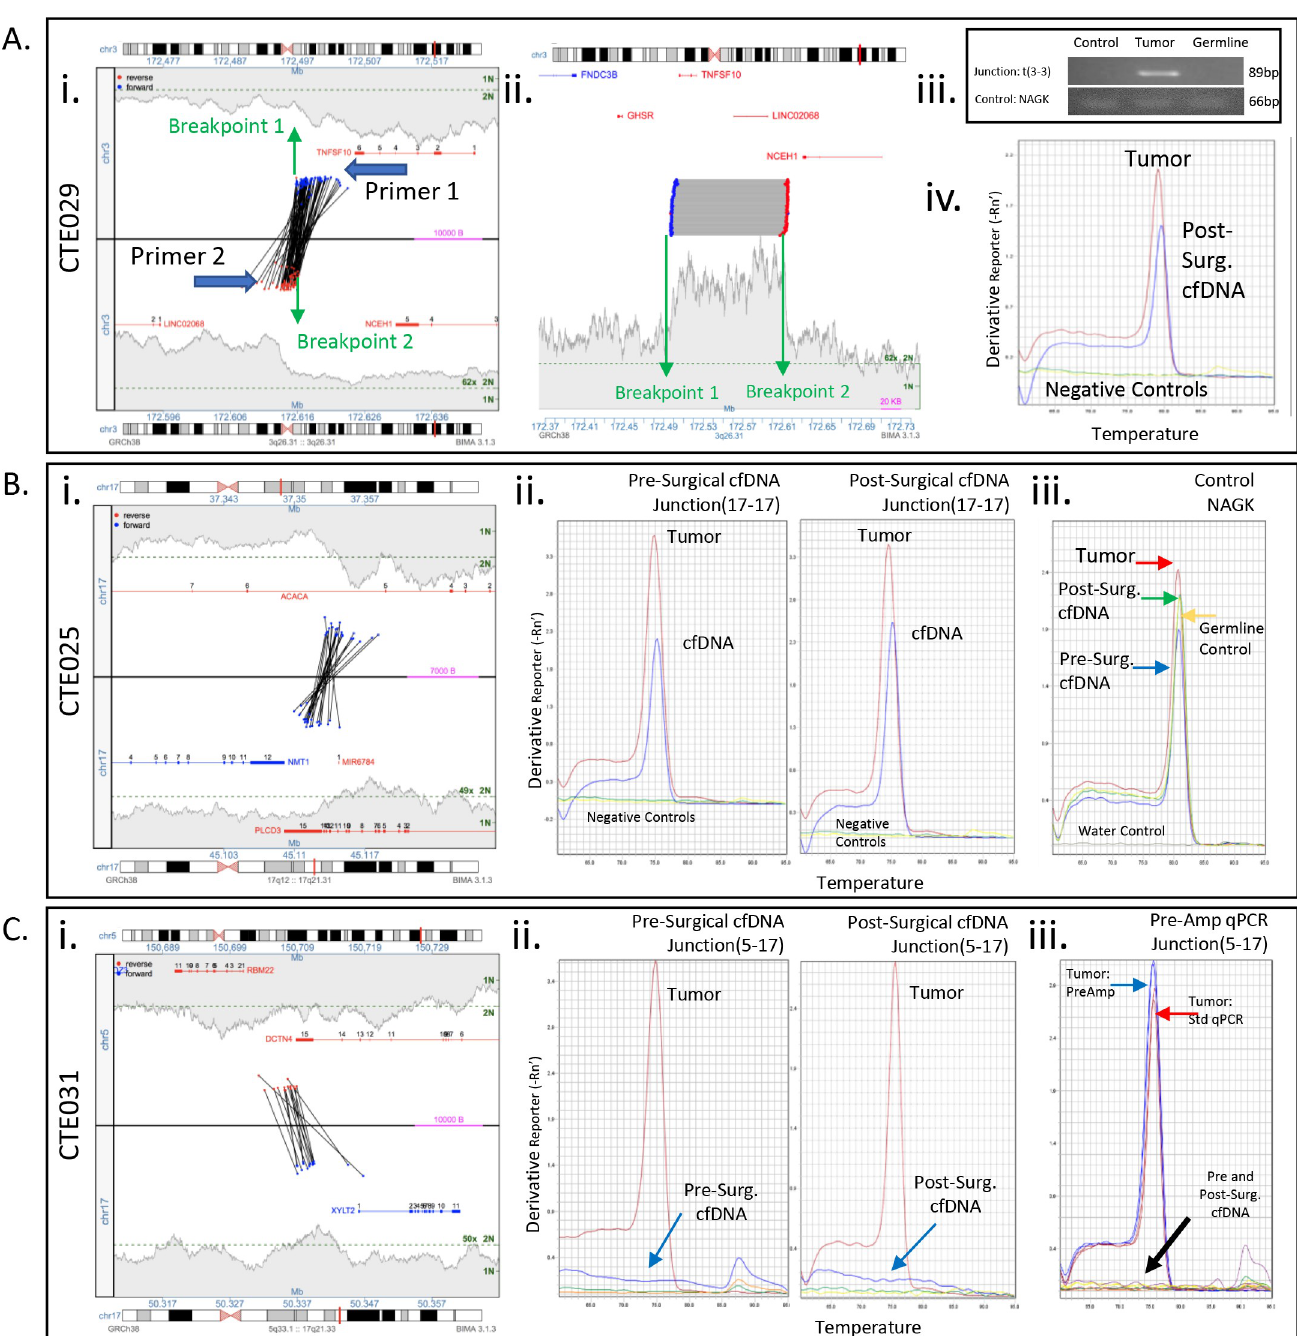
Fig 3. Junction primer design and qPCR cfDNA detection results. (A) Case CTE029. Left Panel : Junction plots of selected intrachromosomal junction of chromosome 3 with base positions 172MB–173MB (3a–3b). The middle line separates the 2 chromosomal areas involved in the junction. The lines across show the fragments that span the junction and support the rearrangement. The position of each read of a supporting fragment is located by a dot and color coded by strand, red for reads mapping to the reverse strand, blue for forward strand. The bridged coverage for the region is illustrated by the shaded area. The green dotted line on the y–axis indicates the bridged coverage averaged across the entire genome (normalized to estimate 2N and 1N). Genes within the region are displayed, indicating exon location and strand direction. General relative positions and directions of designed primers indicated. Middle panel : Linear plot of junction. Right Panel : Standard endpoint PCR of junction 3a–3b and amplification control product NAGK in pooled genomic DNA, patient tumor, and patient PBMCs. Sybr green qPCR amplicon melting curve for 3a–3b junction in patient 6–week post–surgical cfDNA. (B) Case CTE025. Left Panel : Junction plot of selected junction. Middle Panels : Sybr green qPCR melting curve of amplicons of 17a–17b junction in patient pre–and post–surgical cfDNA. Right Panel : qPCR melting curve for control product NAGK. (C) Case CTE031. Left Panel : Junction plot of selected junction. Middle Panels : Sybr green qPCR melting curve of amplicons of 5–17 junction in patient pre–and post–surgical cfDNA. Right Panel : qPCR melting curve for junction 5–17 in presurgical cfDNA following 30 cycles of pre–amplification. https://doi.org/10.1371/journal.pone.0252390.g003 PLOS ONE | https://doi.org/10.1371/journal.pone.0252390 June 10,